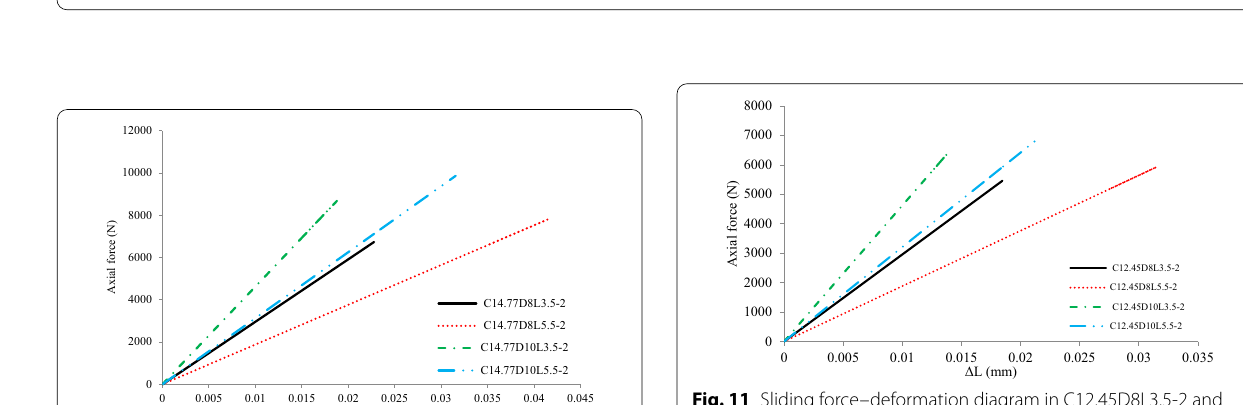
Fig. 9 Strain–stress diagram of specimens: a C14.77D8L3.5, b C14.77D8L5.5, and c C14.77D10L3.5 with different confinement levels.